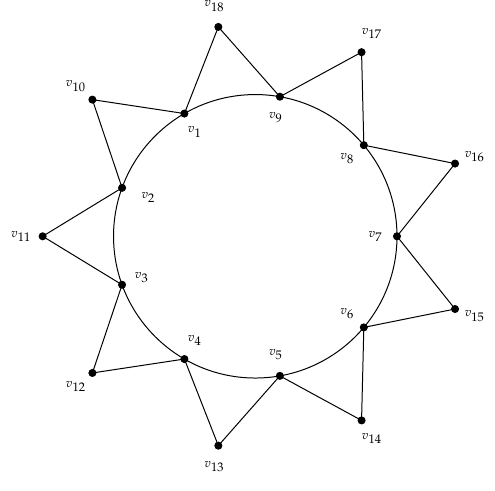
Figure 2. Flower graph f 9 × 3